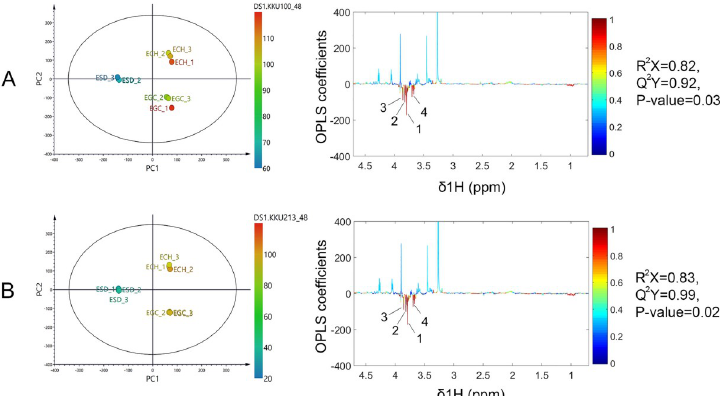
Fig 8. O-PLS sores and corresponding coefficient loading plots displaying significant metabolites with cell viability on (A) KKU-100 and (B) KKU-213. (1,4 = lignin compound 2012, 2 = glycyl-glycine, 3 = allose).